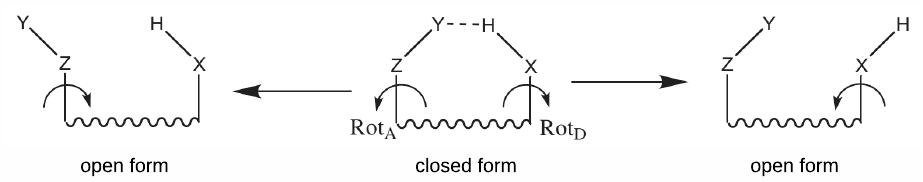
Figure 1. Scheme showing two open forms obtained by rotation of either the hydrogen-acceptor (lhs) or the hydrogen-donor (rhs)